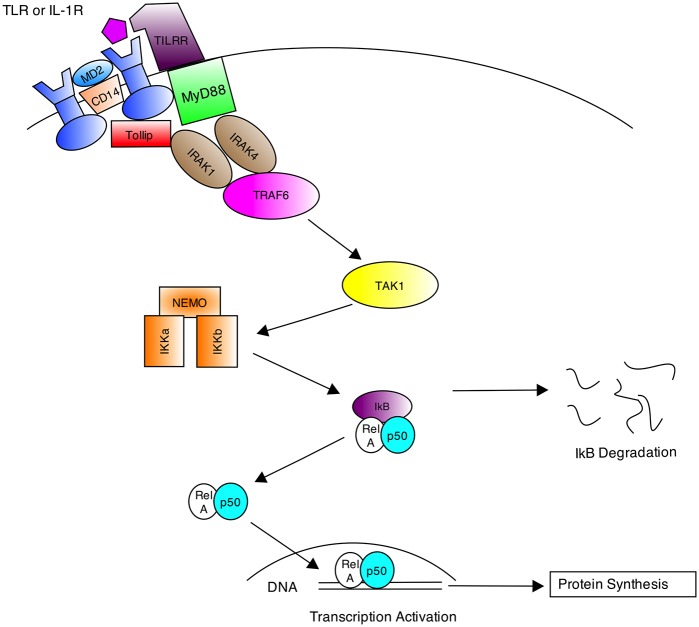
Cartoon diagram of high-level interactions.Simplified cartoon diagram depicting the high-level interactions between the TLR or IL-1R superfamily of receptors, the co-receptors and adaptor proteins, and the protein kinases within the NF-κB canonical signalling pathway. Diagram developed from findings of [51–55].